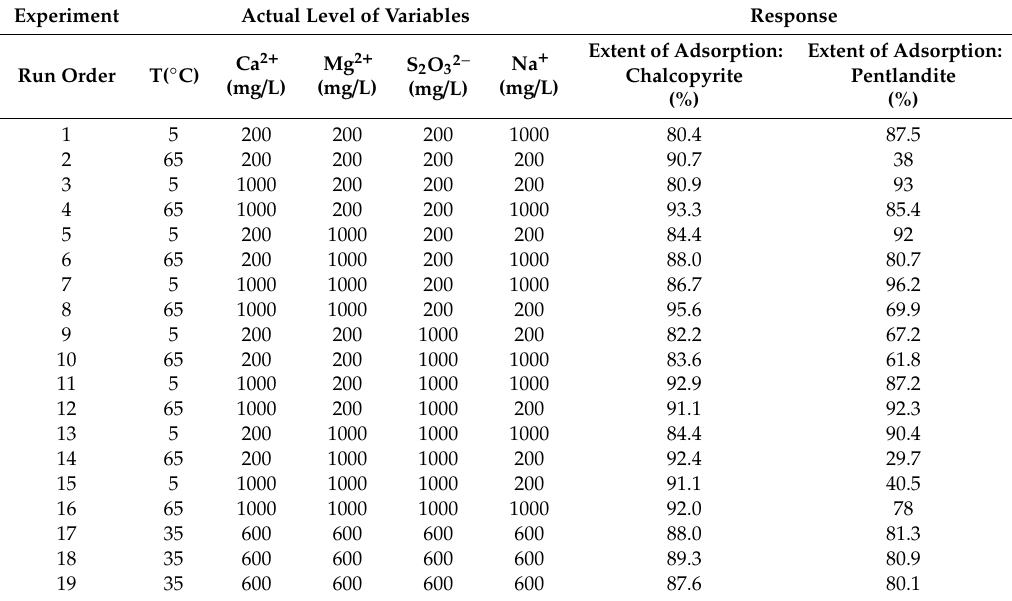
Table 2. Summary of the 2 level half fractional design experimental